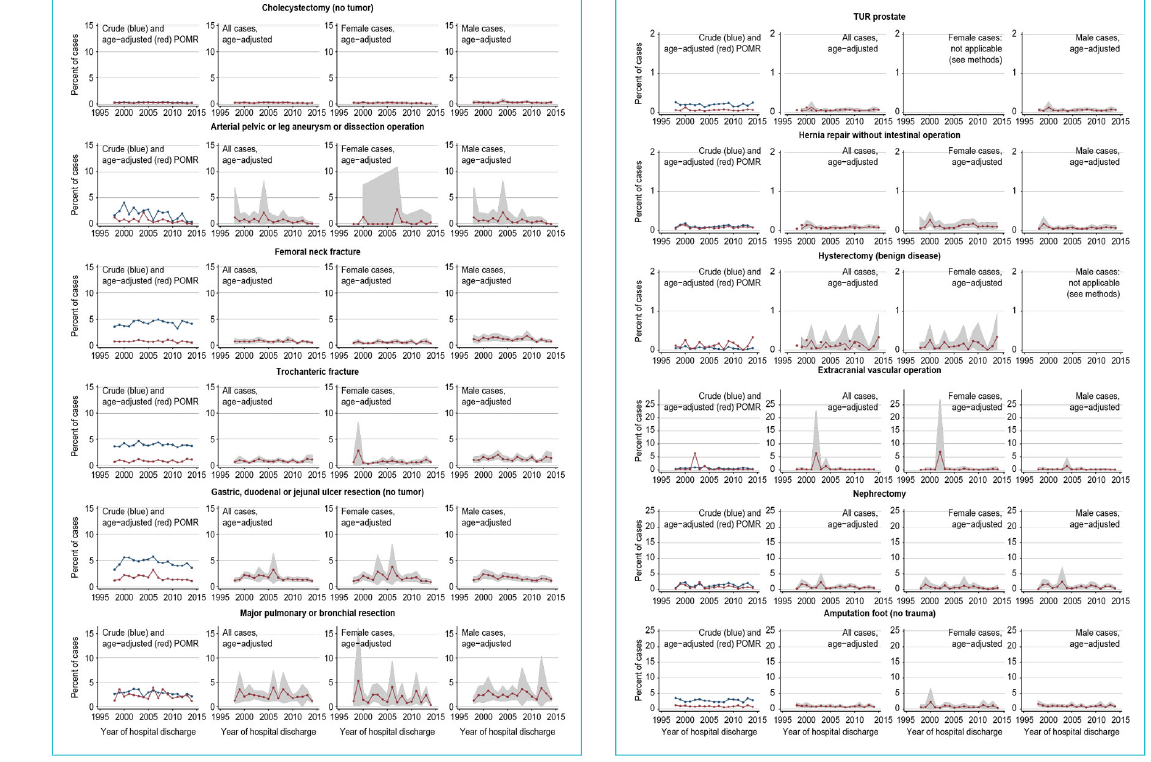
Figure 1: Decreasing POMR trends in low- to intermediate-risk IORs.Note: POMR = perioperative mortality rate.